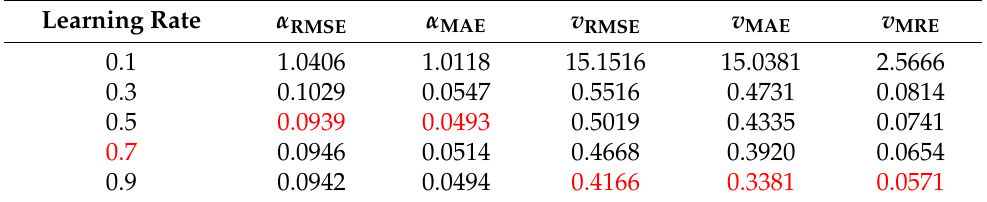
Table 4. Prediction results of different learning rates for front wheel angle and speed.